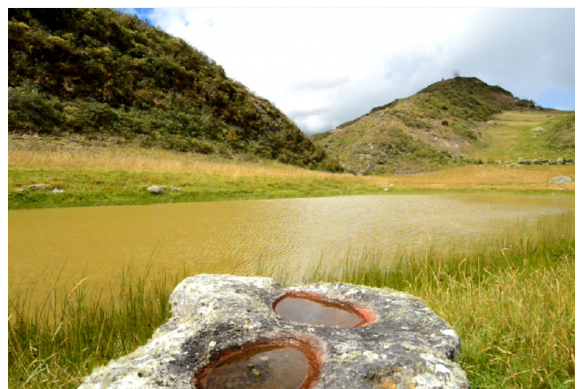
Figure 2. Heritage buildings of Nabón. Source: Municipality of Nabón (2019)